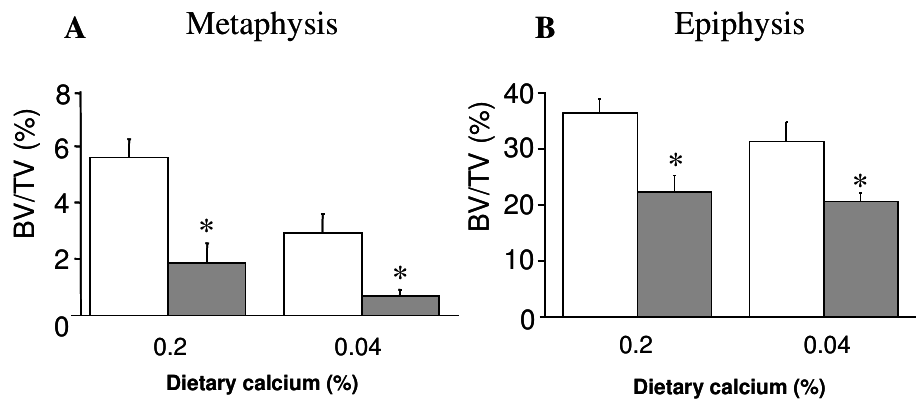
Figure 1. Trabecular bone volume (BV/TV) in the distal femora from 10-month old Sprague-Dawley rats following 4 months of dietary calcium feeding and 3 months post-operation: ( A ) Metaphyseal region; ( B ) Epiphyseal region. White bars: ovary-intact, sham operated; Grey bars: oophorectomized.